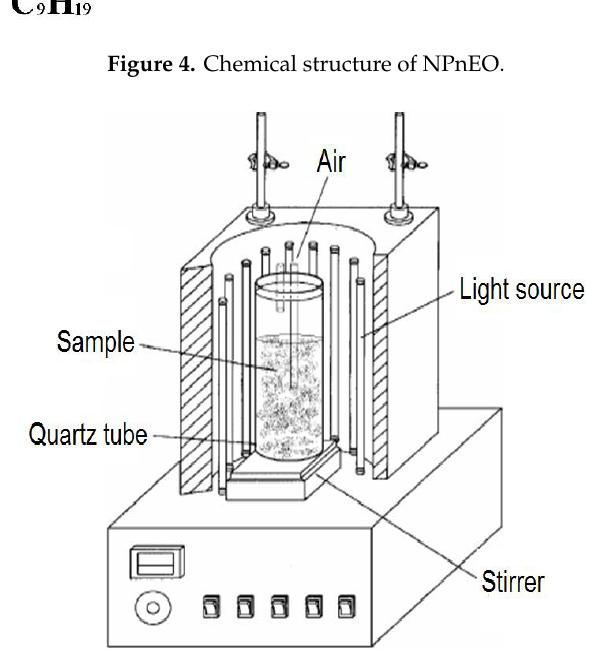
Figure 5. Schematic representation of the custom-made photoreactor.